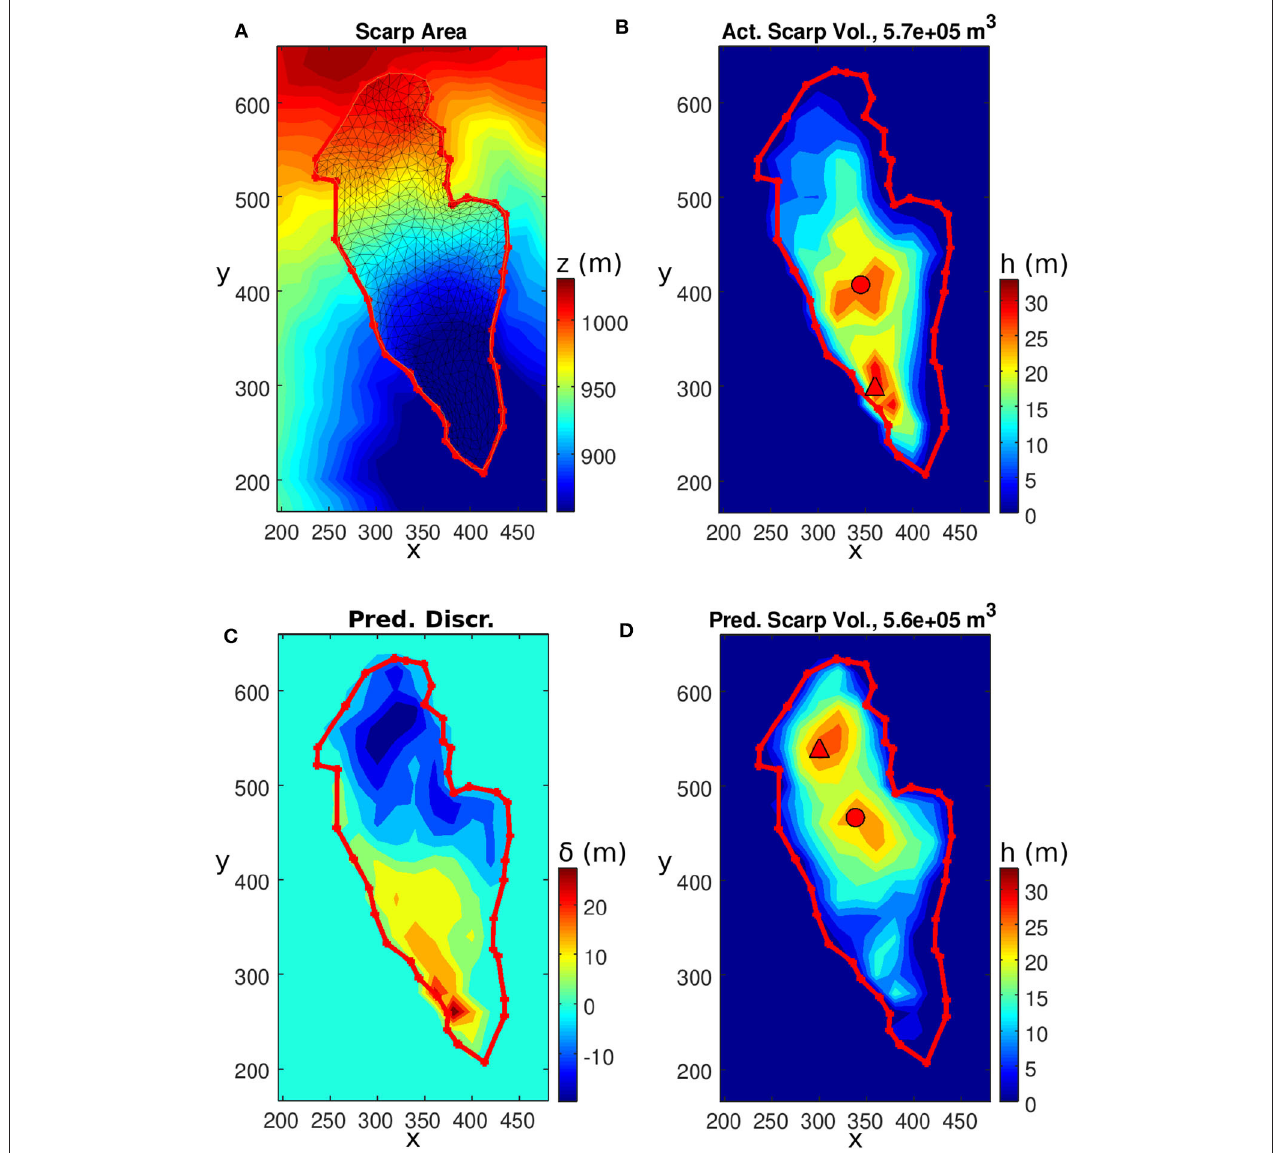
FIGURE 8 | Landslide FID18. Clockwise from the upper-left figure (A) The topography, scarp outline and smooth minimal surface computational domain. (B) The actual landslide depth and scarp outline. (C) The predicted landslide depth. (D) The prediction discrepancy δ ( x , y ). The solid red circle and triangle represent the gravity center and maximum depth location,